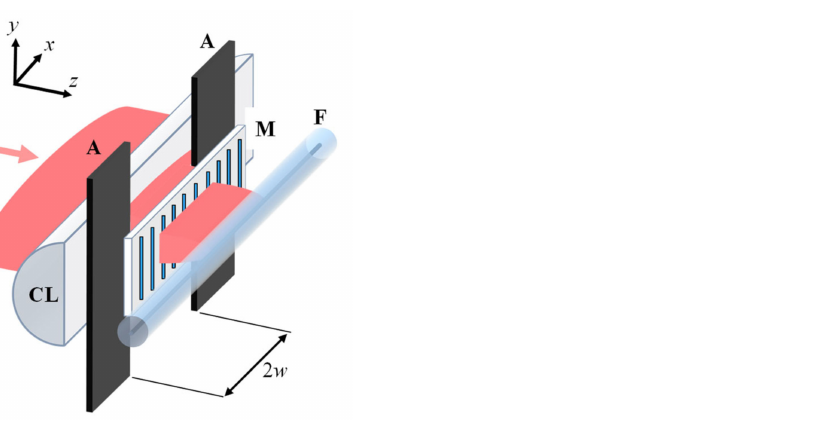
Figure 20. Schematic of the setup for inscription of π -phase-shifted Type II FBG.